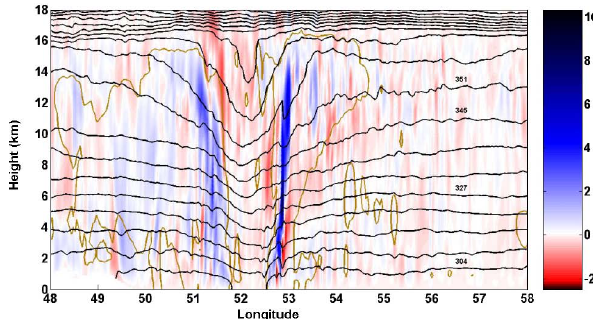
Fig. 10. Vertical cross section of vertical wind velocity (ms − 1 ) across the storm centre at 16.1 ◦ S on 16 February 2008 at 12:00UTC. The black and brown solid lines respectively indicate iso-theta contours and the boundary of cloud, which is defined by the region where the sum of mixing ratios is > 0.1gkg − 1